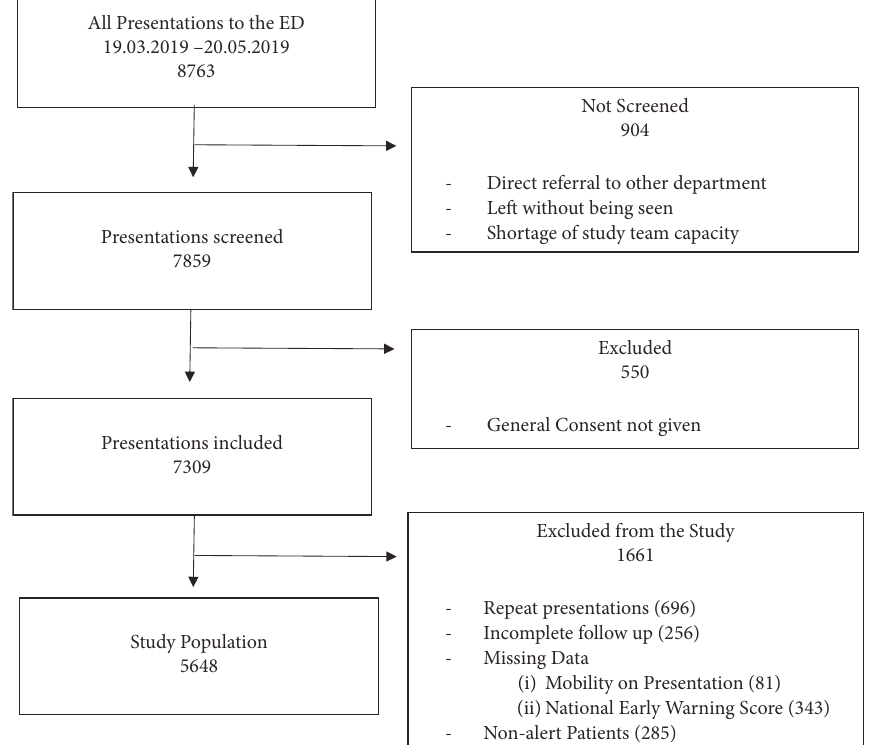
Figure 1: Recruitment and inclusion procedure for study population: This figure shows the recruitment and inclusion/exclusion procedure of the study population (ED = emergency